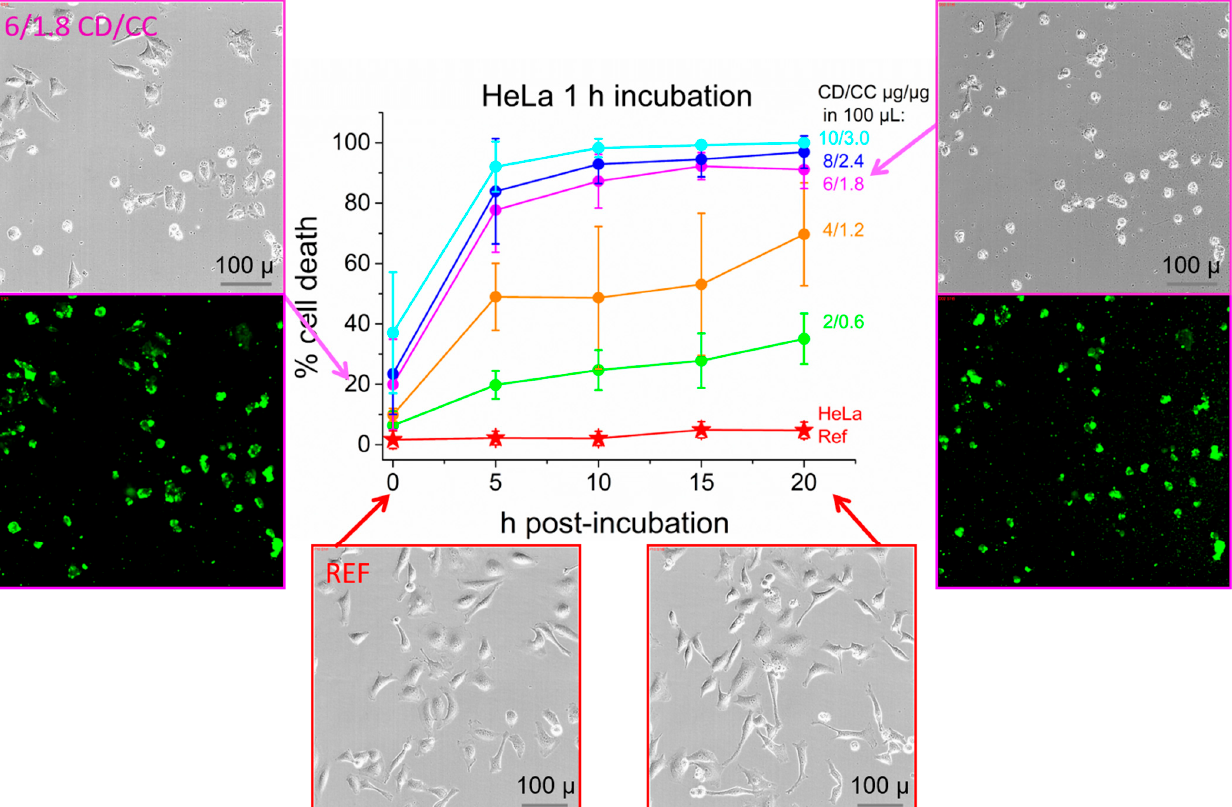
Figure 5. Concentration-dependent kinetic response curves displaying cell mortality in HeLa cells, incubated for 1 h with CD-CC-NP (molar ratio 1:1). Representative images after medium change (0 h, left) and at 20 h post-incubation time (right) are shown (CD/CC = 6/1.8 µg/µg). Purple color-coded images refer to the purple sample in the graph. Untreated HeLa cells are shown in red, images were taken at time points as indicated by arrows.